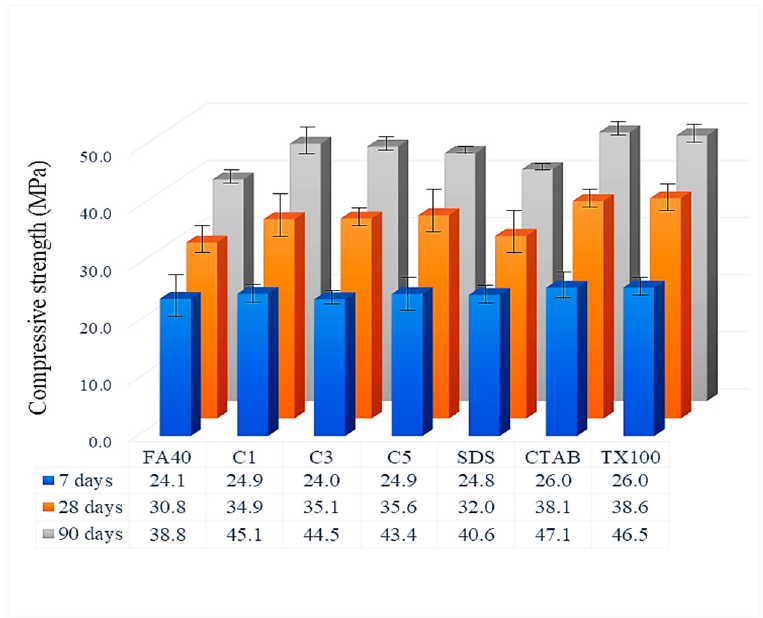
Figure 9. Compressive strength of FA blended cement mortar at 7, 28 and 90 days via varying α -Fe 2 O